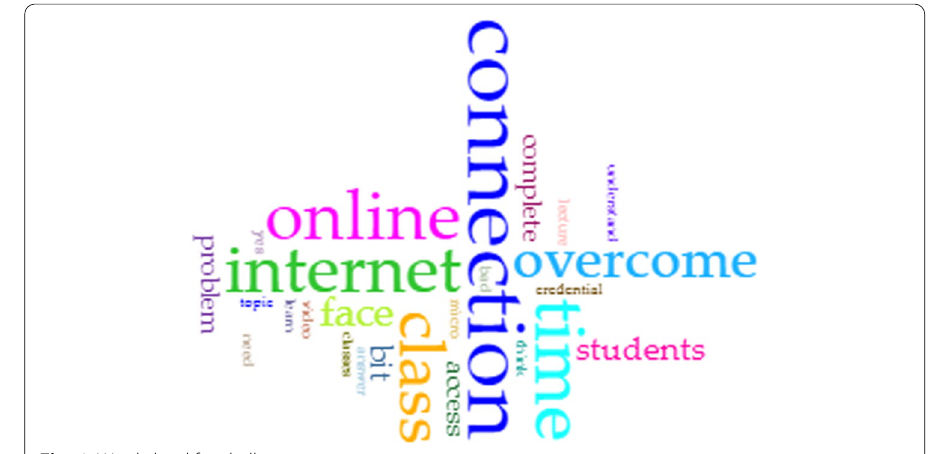
Fig. 6 Word cloud for challenges